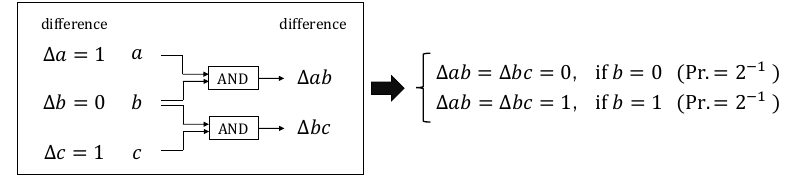
Figure 7: Dependency of two AND gates that appears frequently in TinyJAMBU